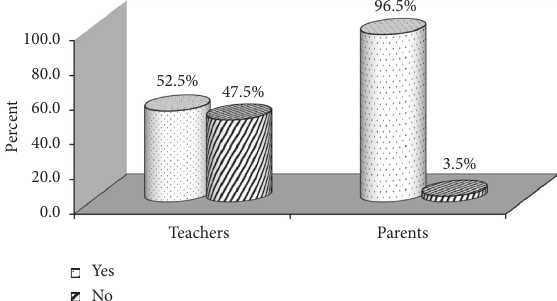
Figure 3: Opinions on the relationship between the agricultural skills developed and food